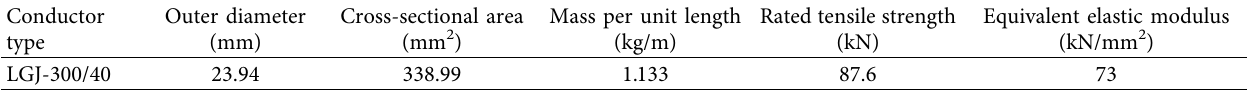
Table 1: Conductor parameters.